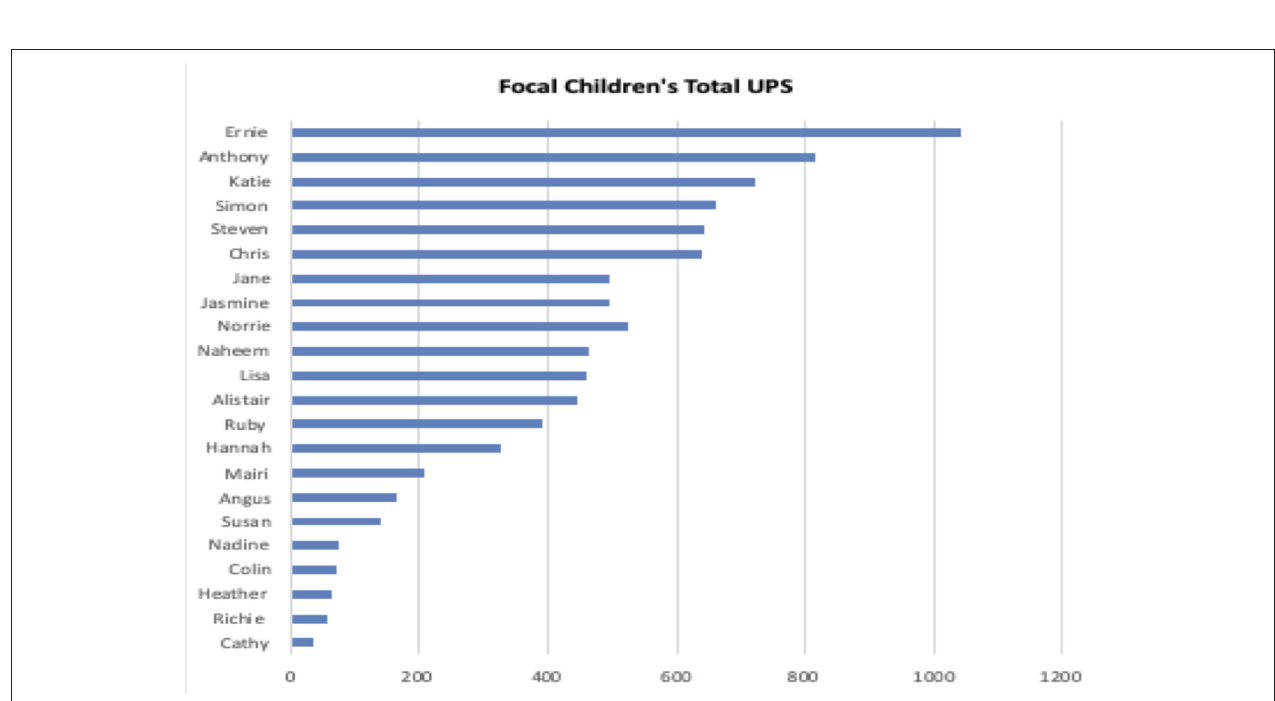
Frontiers in Education |